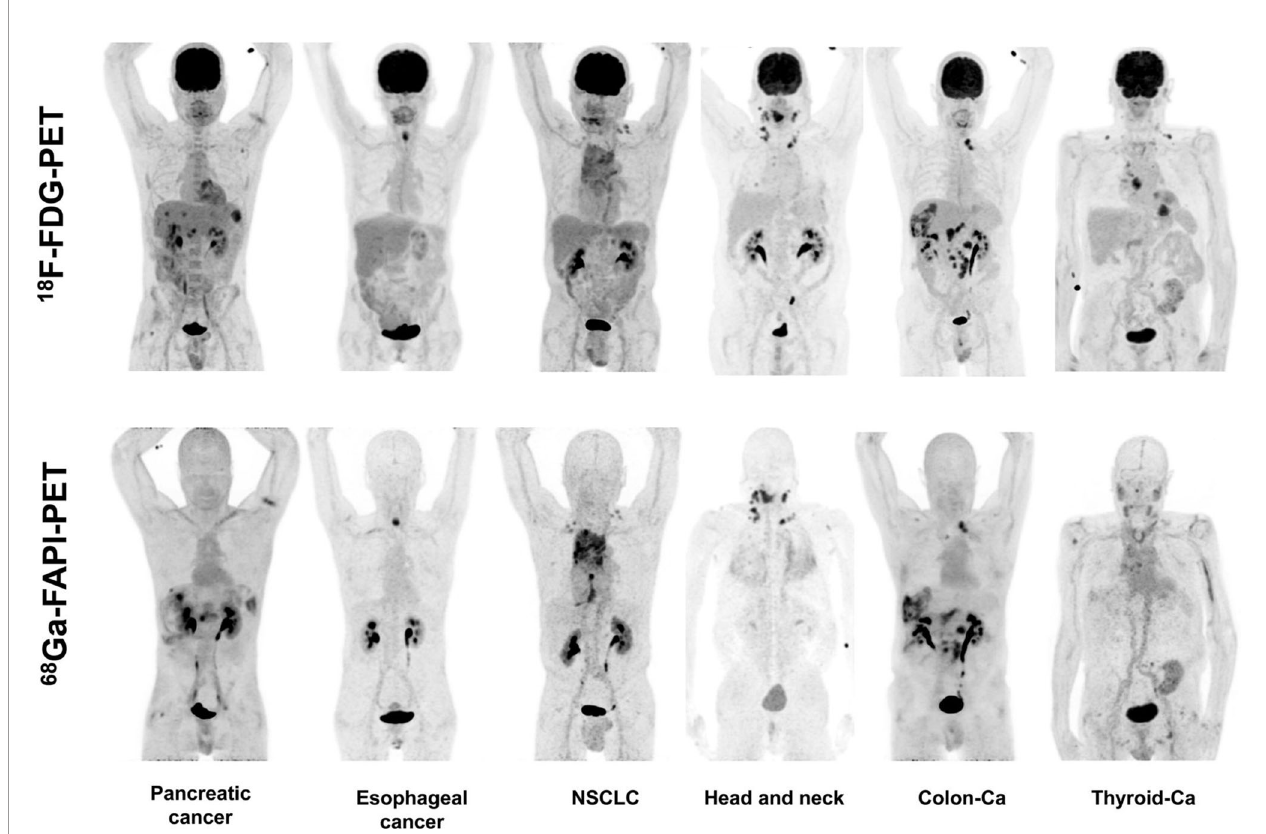
FIGURE 1 | Six patients underwent intra-individual comparison of 18 F-FDG-PET and 68 Ga-FAPI-PET imaging over a 9-day period. Five of the six patients showed similar high tumor uptake in 18 F-FDG-PET and 68 Ga-FAPI-PET, and three of the six patients had more lesions detected due to low background uptake in the visceral or pharyngeal mucosa. Patients with iodine uptake negative thyroid cancer exhibited low 68 Ga-FAPI tracer uptake compared with 18 F-FDG-PET; Ca, cancer; NSCLC, non – small cell lung cancer